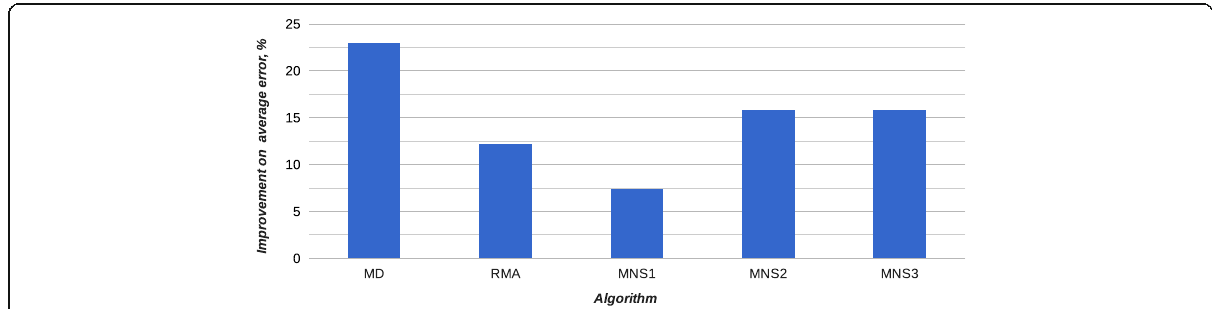
Fig. 13 Improvement on the average error after the post-processing. Evaluation performed on Q resolution training dataset